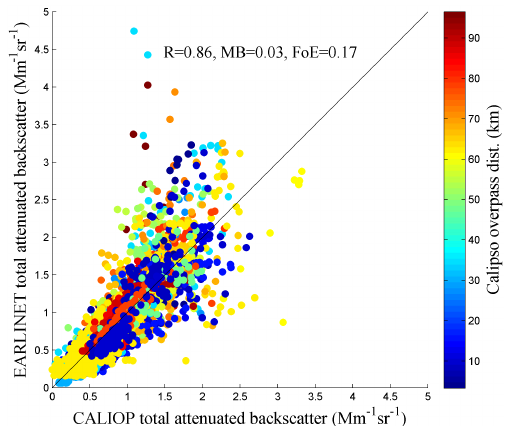
Figure 6. CALIOP vs EARLINET total attenuated backscatter for CALIOP overpasses over EARLINET stations within 100km ground track offset distance. The colour scale shows the ground track distance from the EARLINET station.